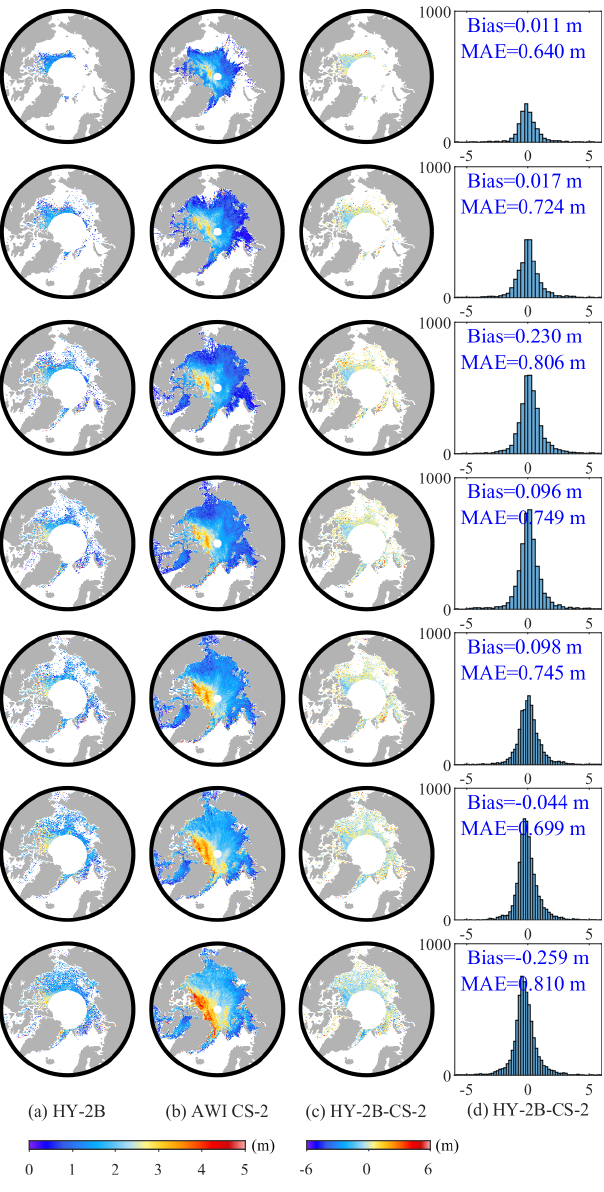
Figure 5. Comparisons and differences between the HY-2B radar freeboard and AWI CS-2 radar freeboard recorded from October 2019 to April 2020: (a) HY-2B radar freeboards, (b) CS-2 radar freeboards, (c) spatial differences between HY-2B and CS-2 radar freeboards, and (d) a histogram of differences between HY-2B and CS-2 radar freeboards.